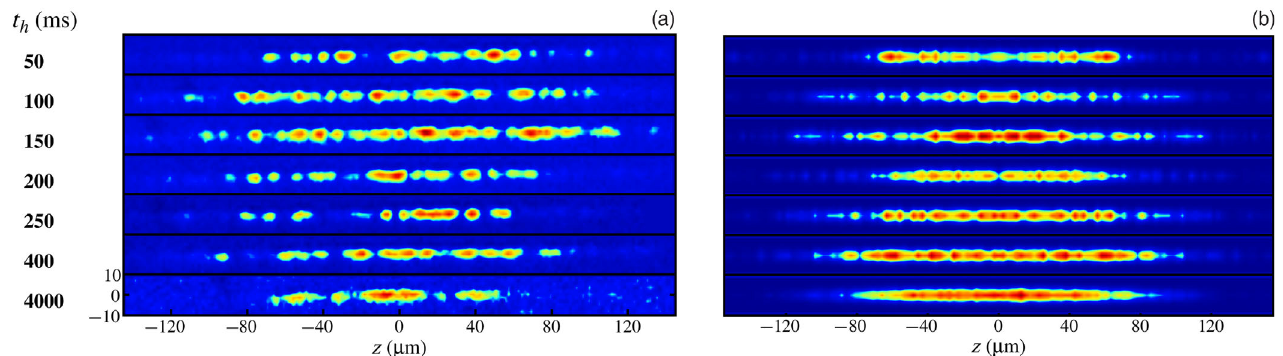
FIG. 6. (a) Experimental images and (b) GP simulations of column-density images for several values of t ¼ 250 ms. The axial and radial trap frequencies for the experiments and simulations in this section are ω and t m ω ¼ ð 2 π Þ 254 Hz, respectively. (a) For the experiment, ¯ B ¼ 577 . 4 G and Δ B ¼ 41 . 3 G, corresponding to ¯ a ¼ 5 a r a − ¼ − 1 a 0 . Each image, with indicated t , is a separate realization of the experiment. (b) Cylindrically symmetric 3D GP simulations h where the calculated 3D densities are integrated along one transverse direction to produce 2D column densities. For the simulations, a þ ¼ 20 a 0 and a − ¼ 0 . 5 a 0